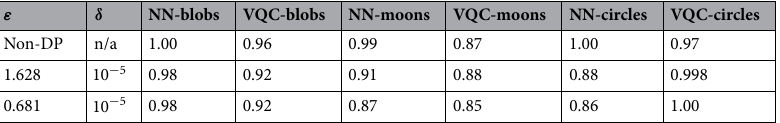
Table 2. Accuracies of differentially private neural networks and variational quantum classifiers after 30 epochs for 2D input sets: “blobs,” “moons,” and “circles.” The quantum classifier can achieve DP with more accuracy for the “circles” set. For the “blobs” and “moons,” the quantum and classical classifier has nearly the same accuracy under a given level of DP.